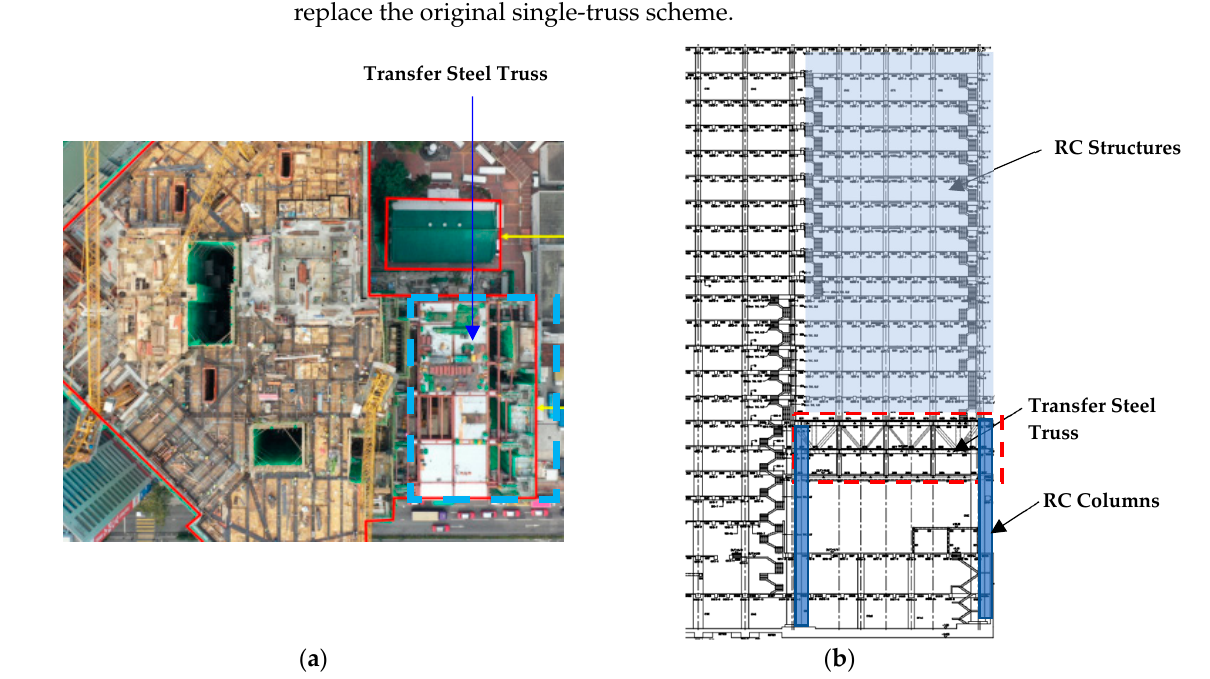
Figure 1. Location of steel trusses in one Hong Kong hospital. ( a ) Aerial view of the project in construction. ( b ) Elevation of superstructure.